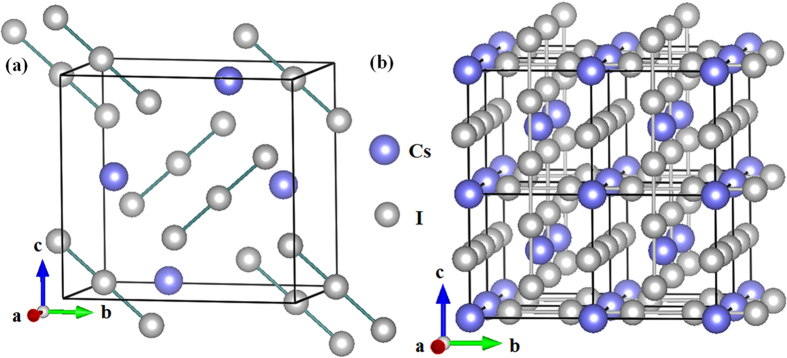
Crystal structures of CsI3.(a) CsI3 at 0 GPa with actual formula of Cs+[I3]−. (b) CsI3 at 10 GPa in a cubic Pm-3n structure.